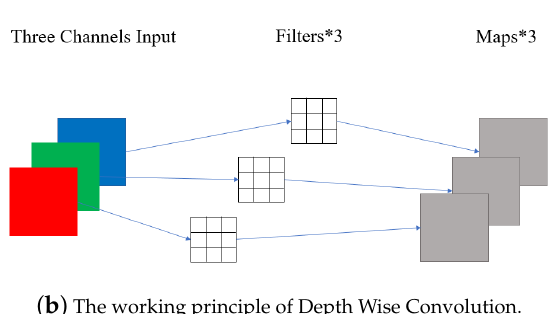
Figure 3. Comparison between Conventional Convolution and Depth Wise Convolution. Different from the Conventional Convolution operation, one convolution kernel of Depth Wise Convolution is responsible for one channel, and one channel is calculated by only one convolution kernel. However, the Conventional Convolution kernels operate each channel of the input picture at the same time. It can be seen from the figure that the calculation amount of Conventional Convolution is three times that of the Depth Wise